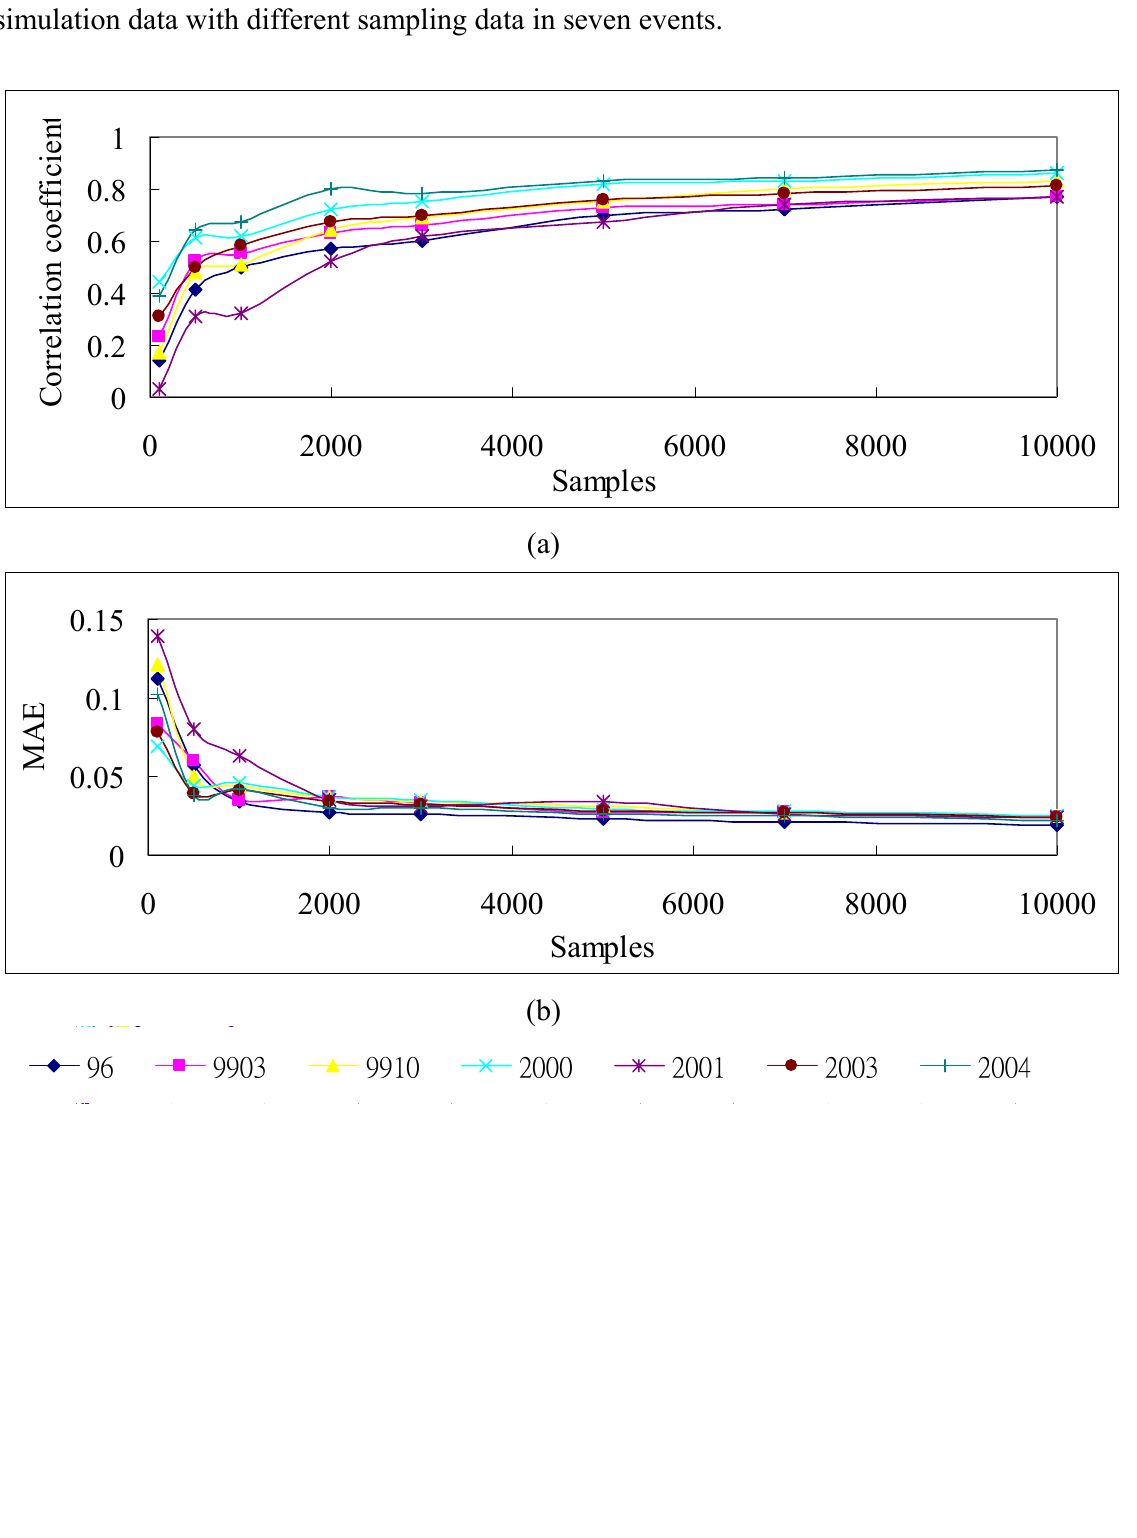
Figure 8. (a) Correlation coefficients and (b) MAE between the original data and SGS simulation data with different sampling data in seven